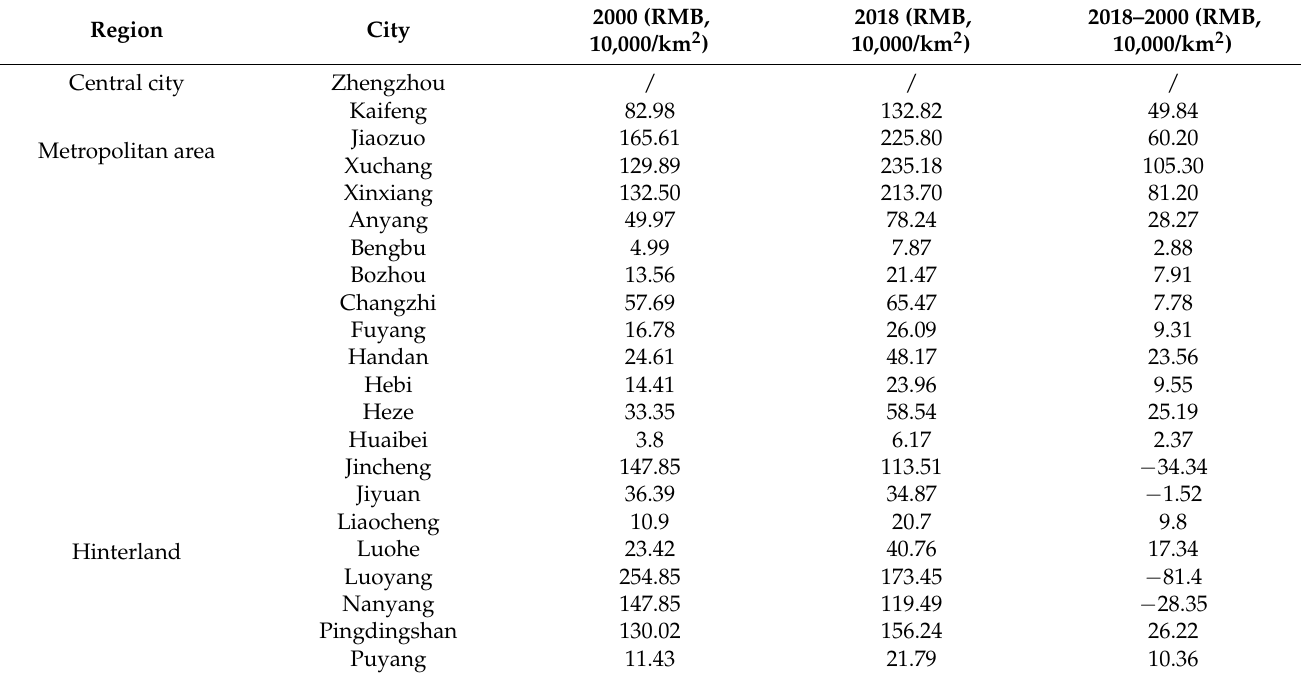
Figure 4. ESV transfer intensity and change of cities in the Central Plains Urban Agglomeration. Table 5. Intensity and change of ESV spatially transferred from the cities to